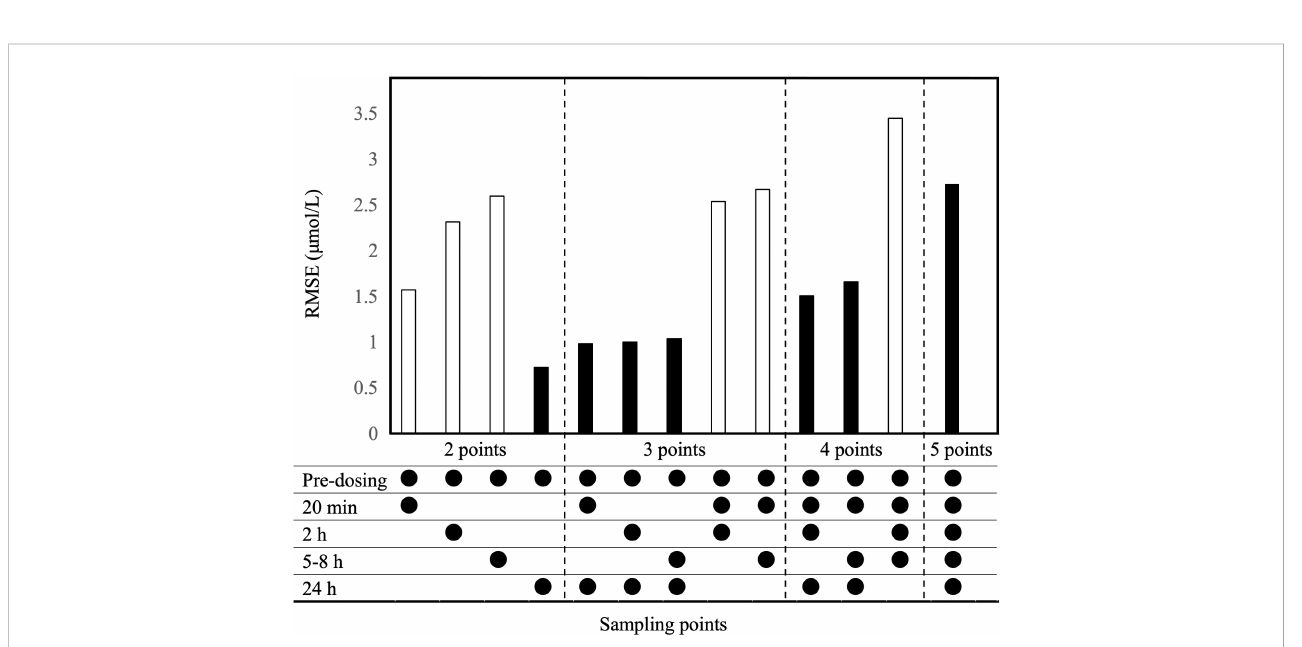
FIGURE 7 Evaluation of RMSE based on the Bayesian estimation of CPG2-MTX popPK-PD fi nal model. Bayesian estimation was conducted for all combinations of sample points. Sampling points are CPG2 pre-dosing, after dosing at 20 min, and 2, 5 – 8, and 24 h. White bars exclude 24-h values in the sample points, while black bars include 24-h values.